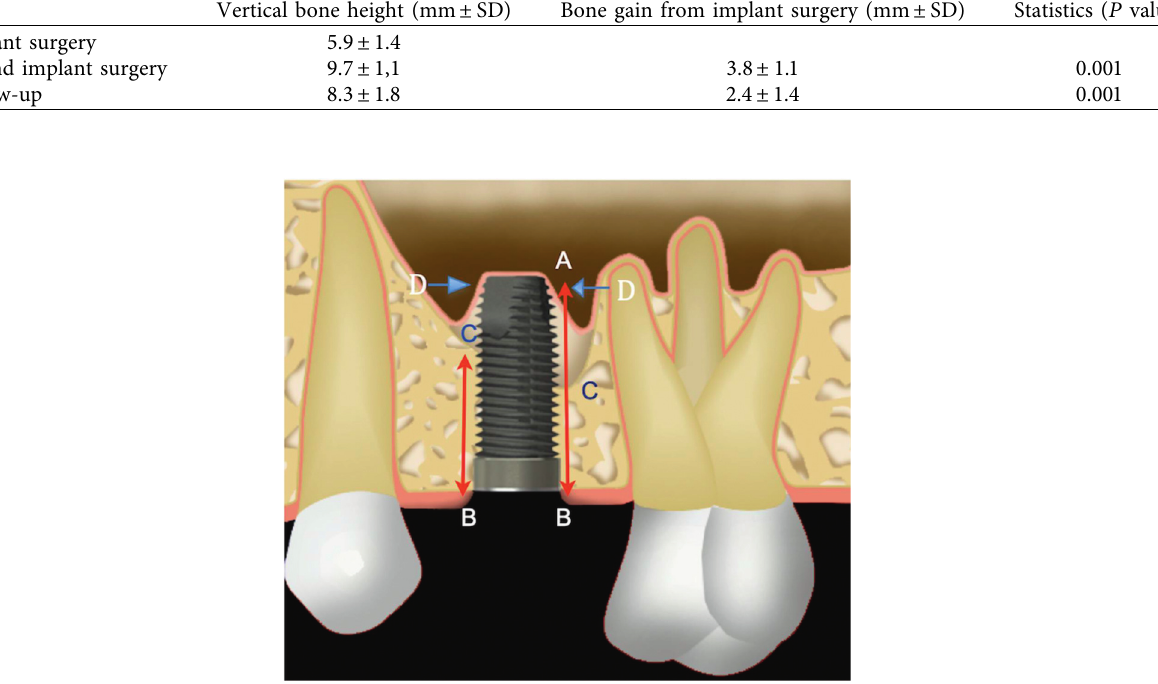
Figure 1: Outline of the parameters measured in the radiographs. A the most apical point of the implant, B the most coronal point of the implant, C the original level of the maxillary floor, D the most apical point of the new maxillary sinus floor. B – C height of residual bone below the maxillary sinus before surgery (RBH). C - A length of the implant inside the maxillary sinus. D most apical point of new bone in contact with the implant. D - C height of bone regeneration within the maxillary